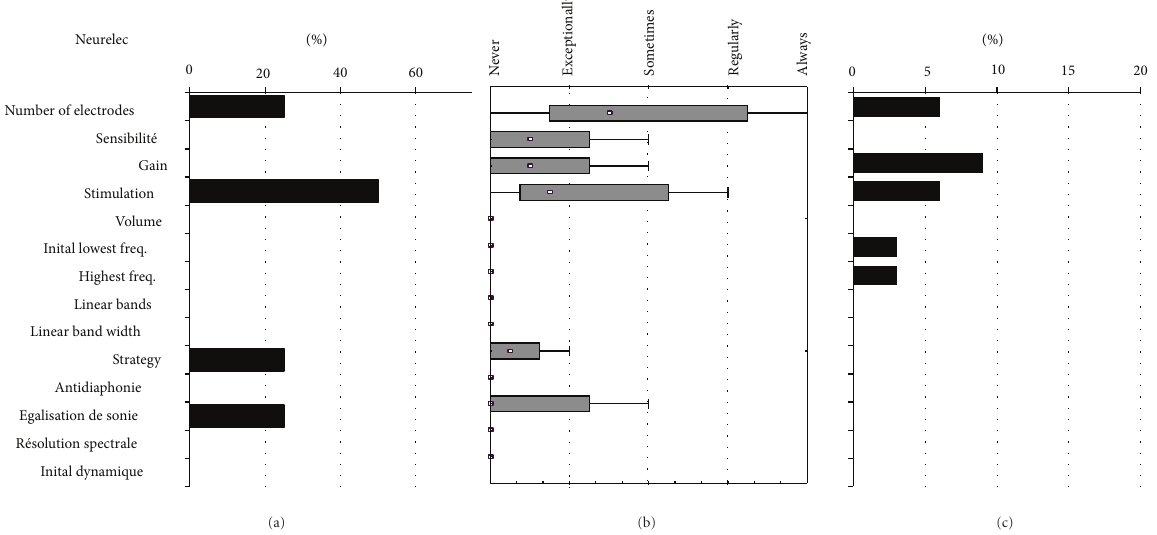
Figure 1: Occurrence of MAP changes for the 4 brands (Cochlear, Med-El, AB, and Neurelec). (a) The left panel shows the frequency of changing the default settings at switch-on, as retrieved from the questionnaire and the interview; (b) the mid panel shows the distribution of the frequencies of changing the MAP parameters during the followup sessions, as retrieved from the questionnaire and the interview (Box and Whisker plots with the central dot depicting the median value, the box shows the quartile range and the whiskers show the range); (c) the right panel shows the occurrence of MAP changes as observed in the cross sectional snapshot.